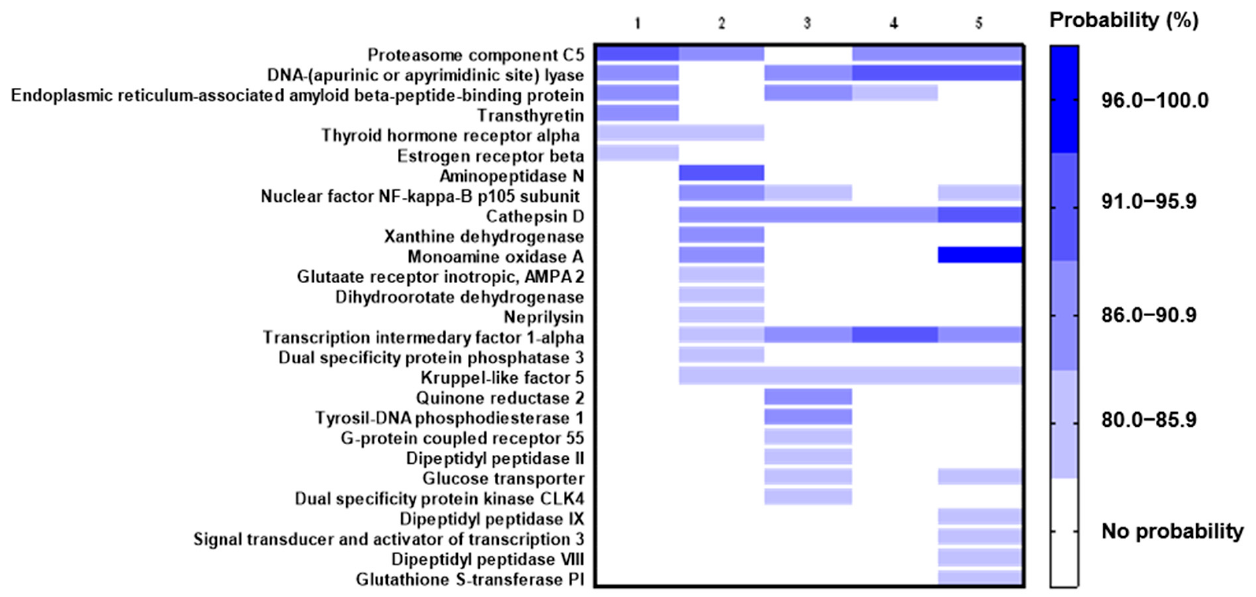
Figure 3. Most probable targets for each evaluated compound (probability ≥ 80%) according to the Super–PRED server. Numbers on the top of the panel indicate the corresponding BCC in Figure 1. On the other hand, the best 15 predicted targets using the algorithm Extended Con-